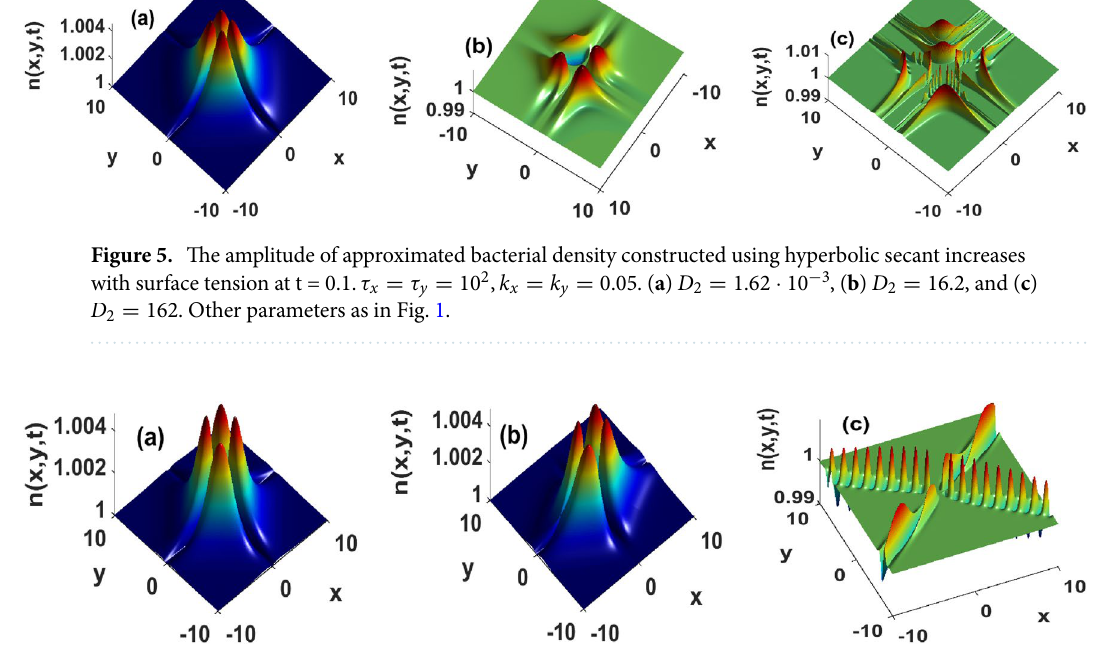
Figure 6. Strong incompressible flows significantly increase the amplitude approximated localized bacterial density determined using hyperbolic secant function at t = 0.1, and for D 2 = 1.62 . ( a ): τ x = τ y = 10 2 , ( b ) τ x = τ y = 1 , and ( c ) τ x = τ y = 10 − 2